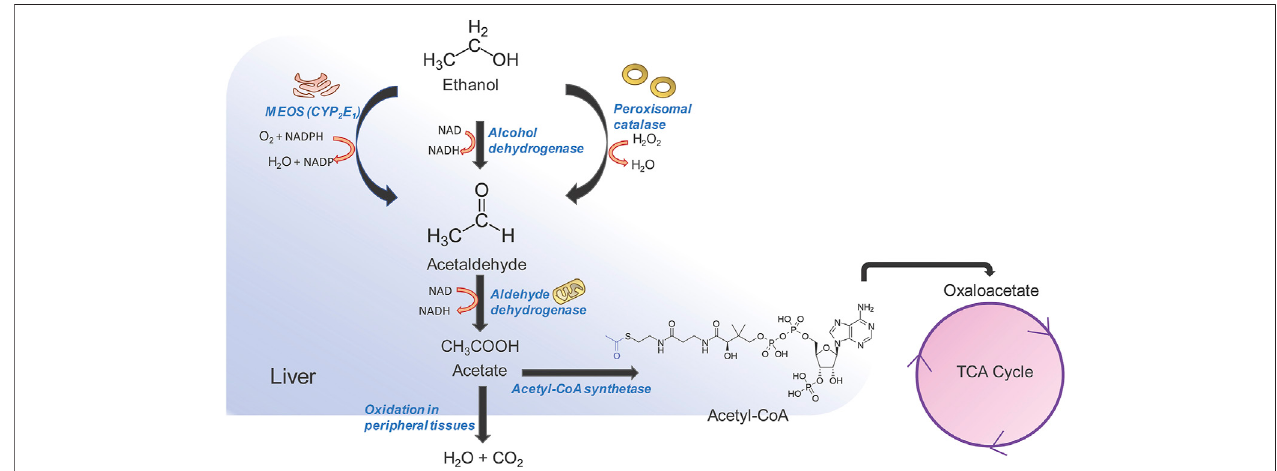
FIGURE 2 | Alcohol metabolism in the liver. Three pathways are involved in alcohol metabolism and all of them converge on the oxidation of ethanol to acetaldehyde. Acetaldehyde is further converted to acetate by aldehyde dehydrogenase in the mitochondria. Acetate can be rapidly oxidized into CO 2 and H 2 O by peripheraltissues,orcanbediverted tothetri-carboxylicacid(TCA) pathway. Theoxidationofethanoltoacetaldehydebymicrosomal ethanoloxidation system(MEOS) occurs in the smooth endoplasmic reticulum and changes the NADPH/NADP ratio which in turn in fl uences the regeneration of glutathione thereby increasing cellular oxidative stress. The alcohol dehydrogenase pathway is the major pathway and occurs in the cytosol, generating large amounts of NADH. NADH in turn inhibits TCA cycle enzymes and leads to accumulation of acetyl CoA and increase in ketone body generation and acidosis. NADH also inhibits fatty acid oxidation leading to accumulation of fats and causing “ fatty liver. ” A combination of the above factors leads to tissue injury and activation of the fi brogenic